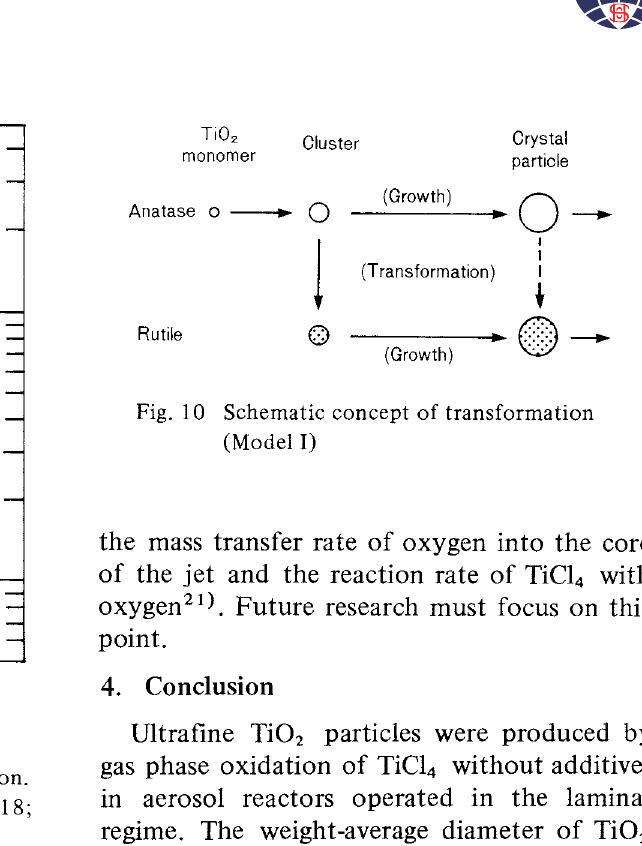
Fig. 9 Arrhenius plot of anatase-rutile transformation.